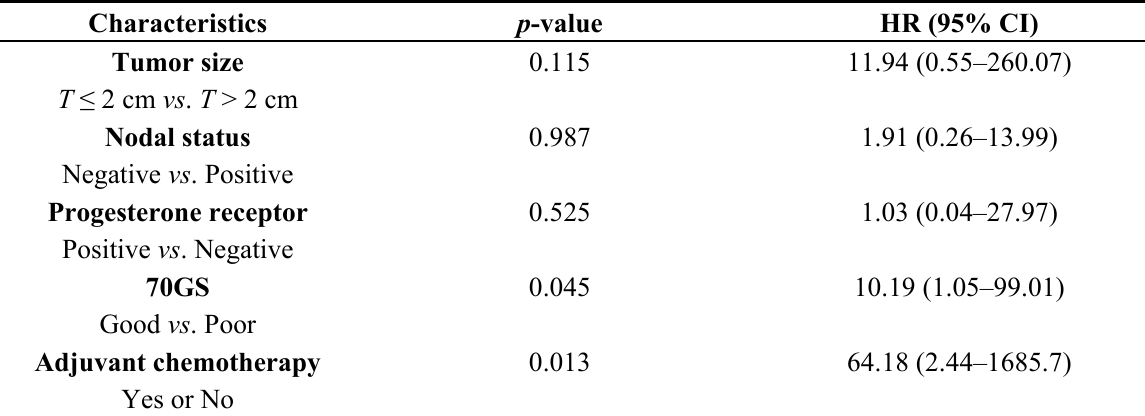
Table 3. Multivariate analysis using the log-rank test according to the